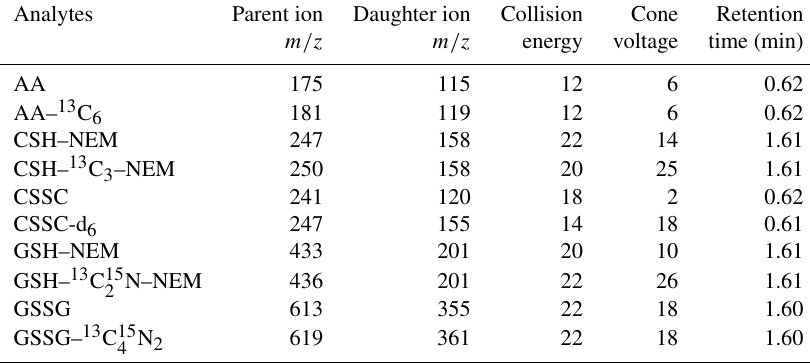
Table 2. LC-MS/MS detection parameters for target substances. Analytes Parent ion Daughter ion